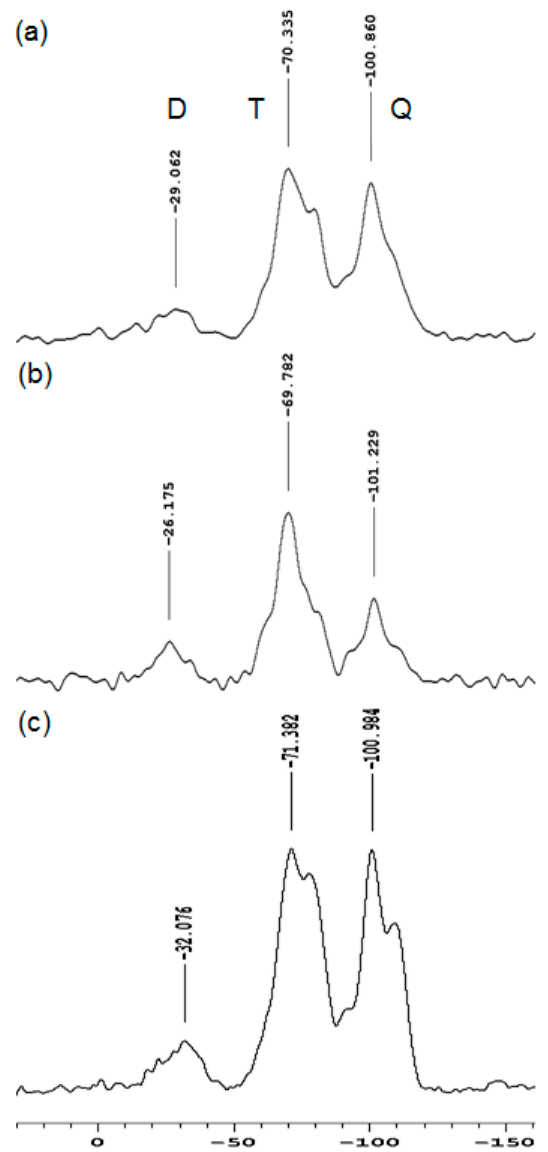
Figure 1. 29 Si CP/MAS NMR spectra of CPS xerogels. ( a ) CPSH, ( b ) CPSOH, ( c ) CPSN. Figure 1. 29 Si CP / MAS NMR spectra of CPS xerogels. ( a ) CPSH, ( b ) CPSOH, ( c )